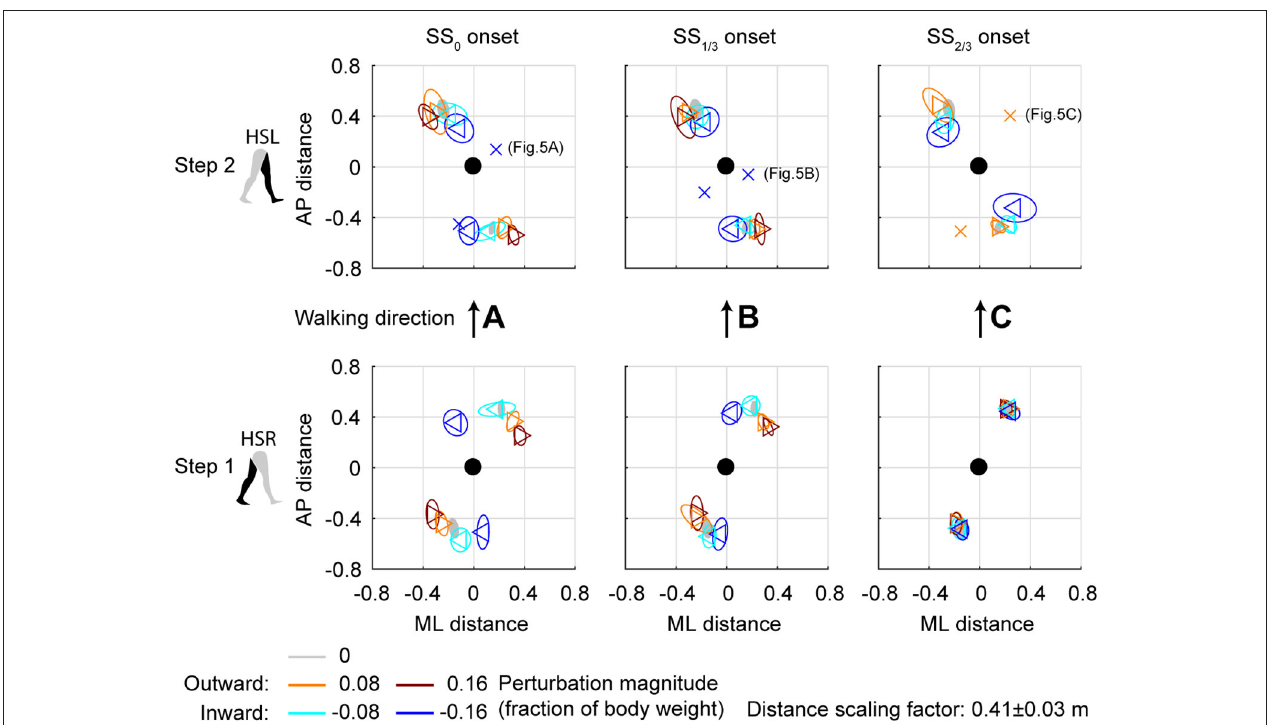
FIGURE 4 | Foot locations following ML perturbations. (A) Top-down view of the locations of the COM of the leading and trailing feet relative to the whole body COM at (0,0). Perturbation onset was at SS 0 . Bottom plot corresponds to the first step (HSR), top plot corresponds to the second step (HSL) after the perturbation. For the second step, one subject deviated from the other subjects. The repetition-average data of this subject is given by a cross. (B) Same as (A) , but for perturbation onset at SS 1 / 3 . (C) Same as (A) , but for perturbation onset at SS 2 / 3 . The subject averages for the 0.16 magnitude SS 2 / 3 perturbation are not shown as it is not representative of any specific stepping strategy, but contains a mixture of three different strategies. Triangles show subject-averages and correspond to the perturbation direction. Ellipses represent the subject-standard deviation. Colors indicate the different perturbation magnitudes. Data is shown dimensionless.